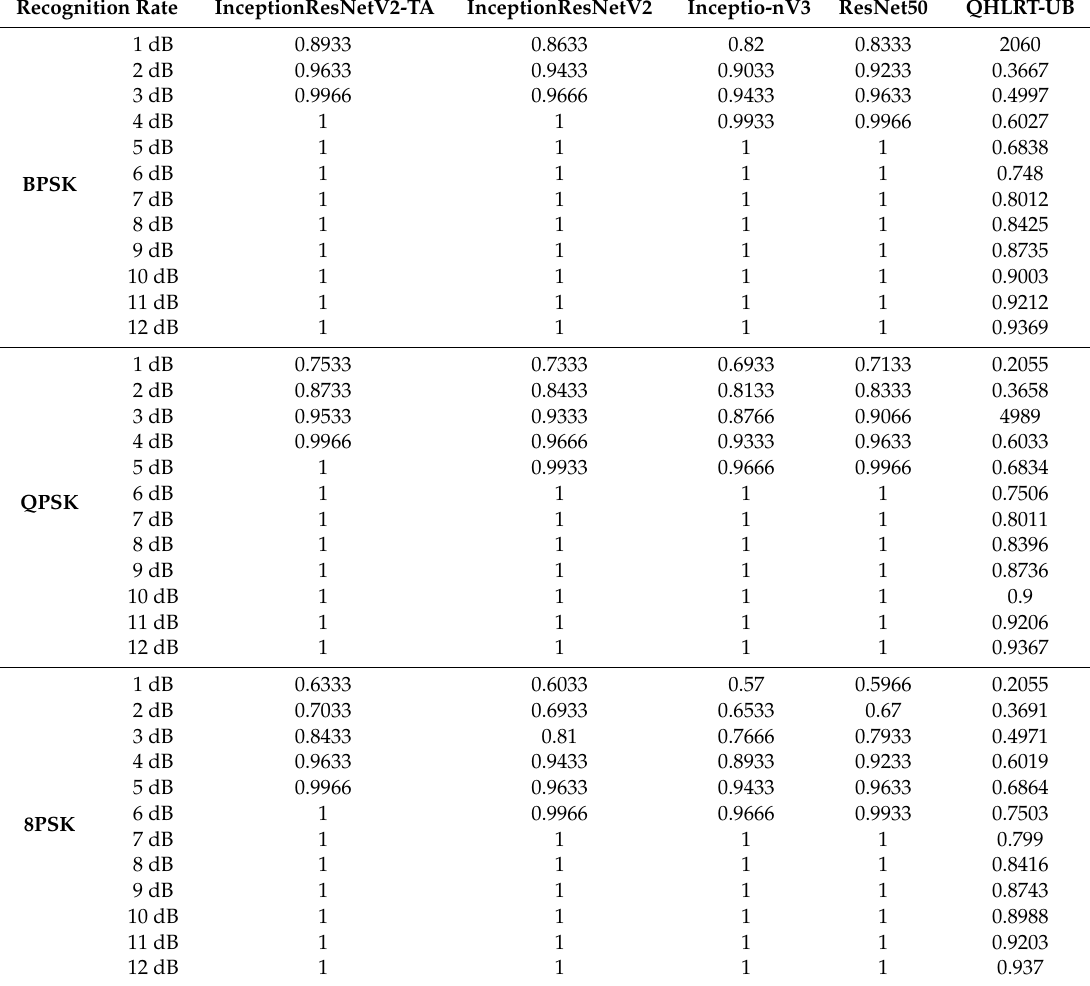
Table 1. Recognition rate comparison of BPSK, QPSK and 8PSK at di ff erent